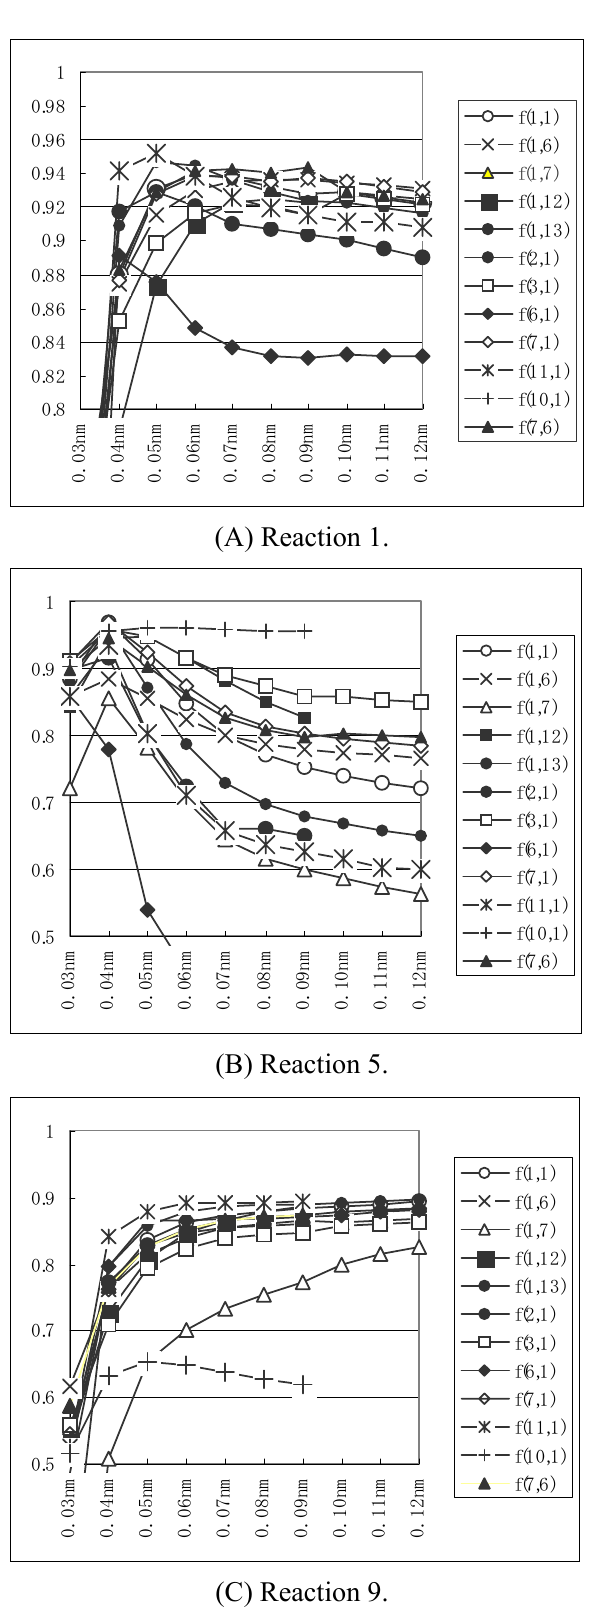
Plots for Some Reactions in Table 2. c